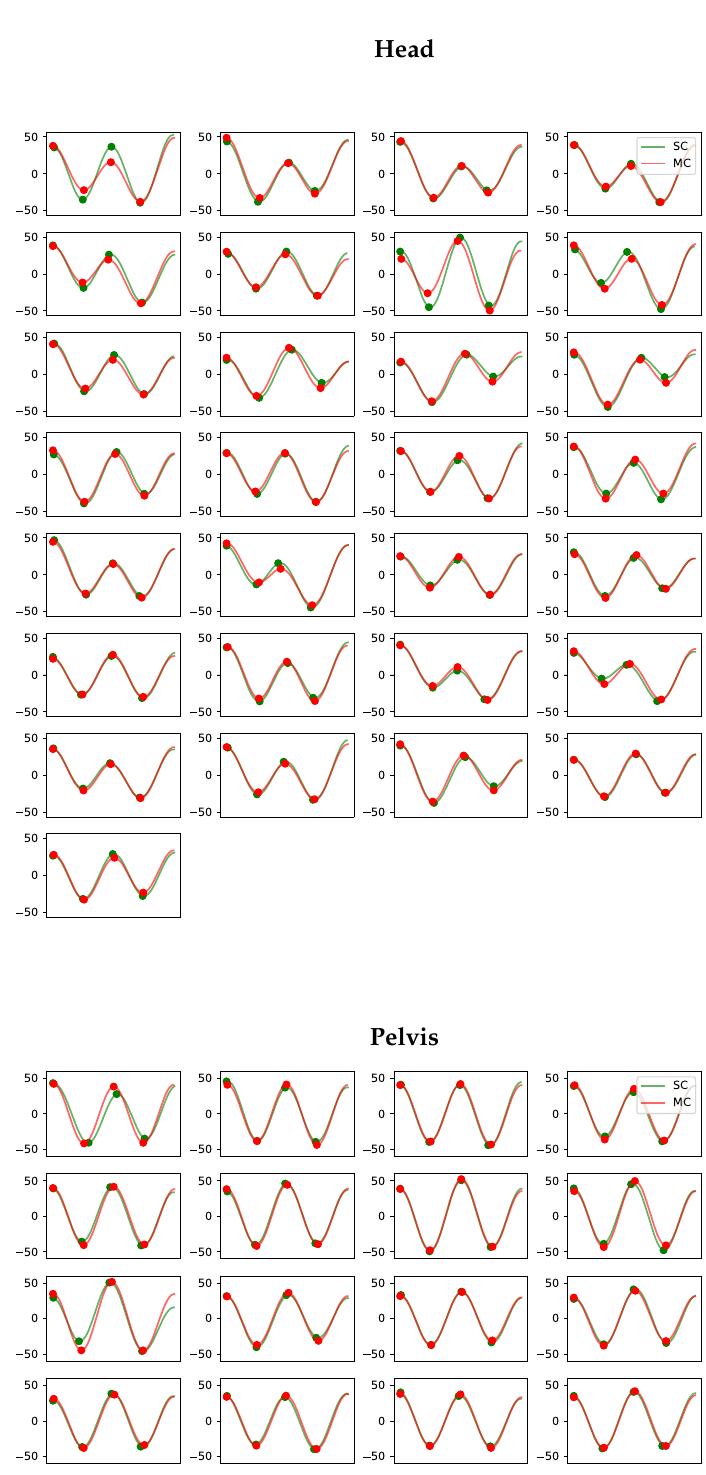
Figure A3. Vertical displacement signals per stride for the head and pelvis for horse 3. Each subplot contains the matched stride segments for the single-camera markerless system (SC) in green and the multi-camera marker-based system (MC) in red. The y-axis shows the vertical displacement in millimeters. The four dots on each curve indicate the positions of the two peaks and two valleys extracted using the approach in Section